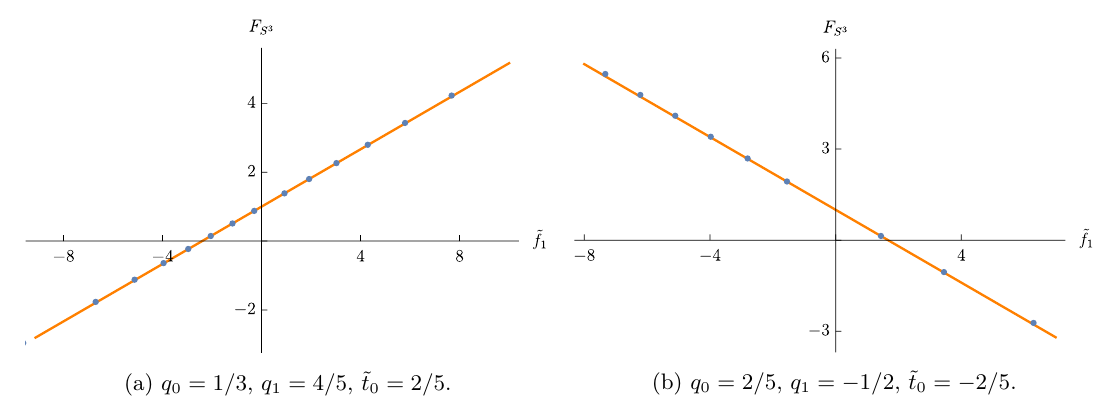
Figure 2. Value S reg in a few examples. The blue points are values of S reg computed numerically and the orange lines are the fit